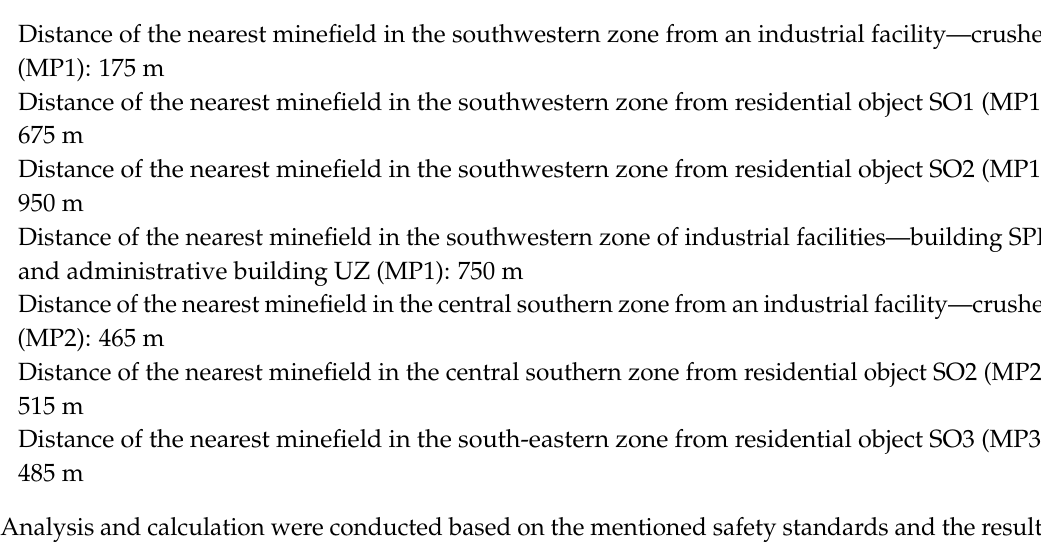
Table 2. Restatement of the calculation results for the allowed explosive quantities simultaneously ignited by the positions and distances between vulnerable objects and the potentially closest blasting fields [23].